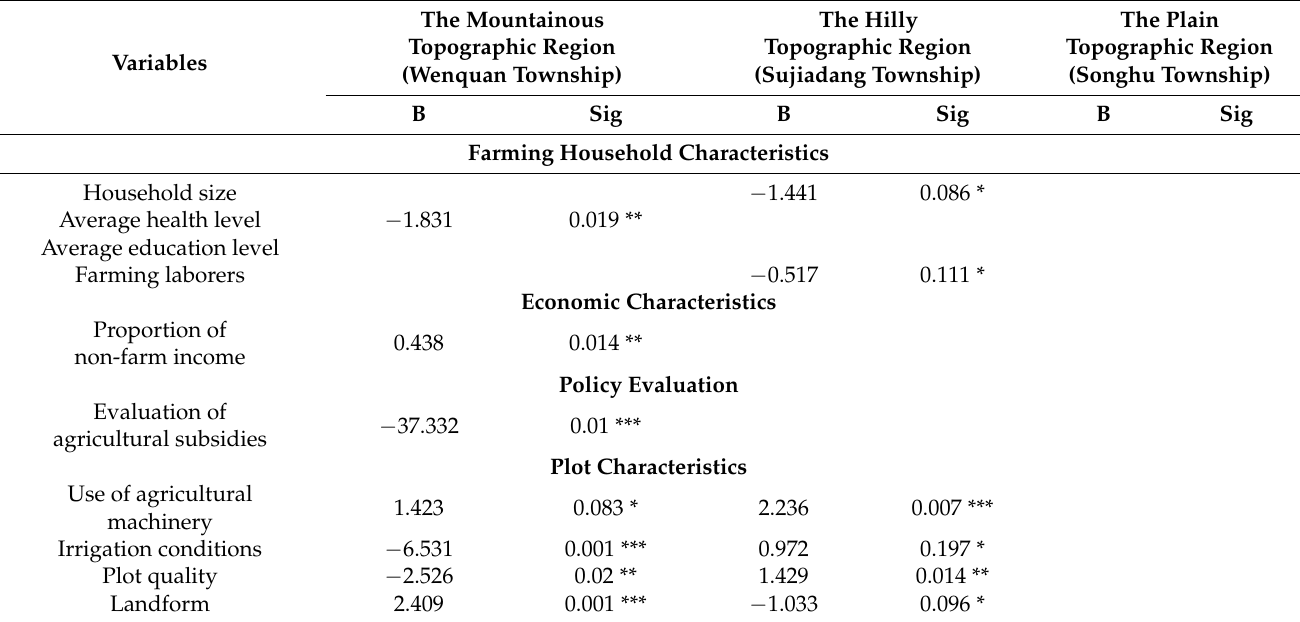
Table 14. Bootstrap sampling results of non-farm households in three topographic